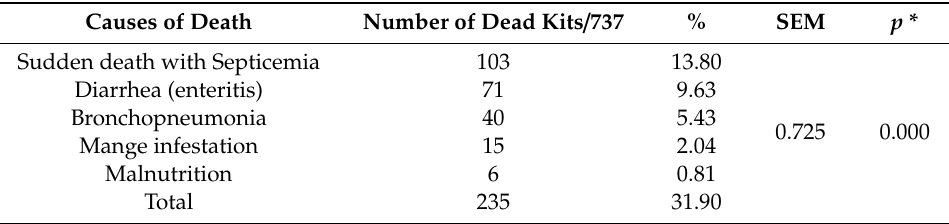
Table 3. Prevalence of postweaning mortality related to the cause of death.